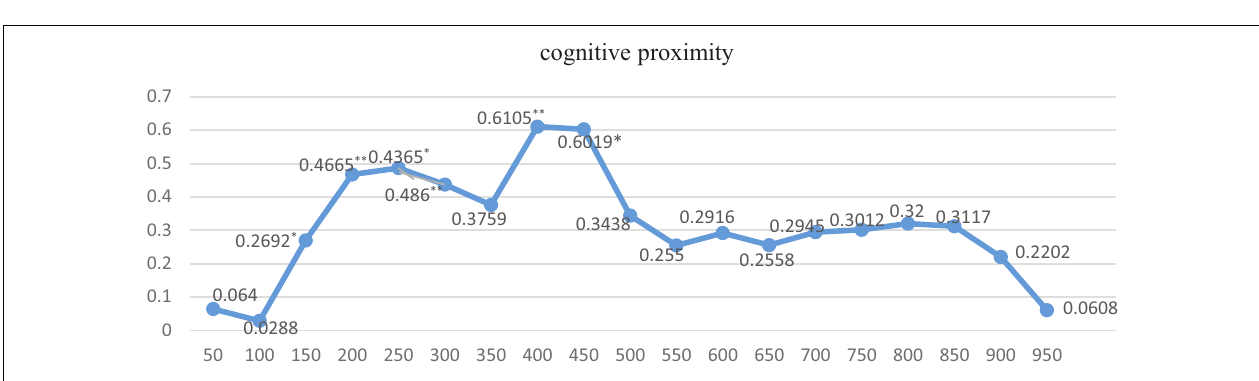
FIGURE 4 | The regression results under cognitive proximity with different kilometers. ** and * indicate that the significance level is at the 5% and 10%, respectively.